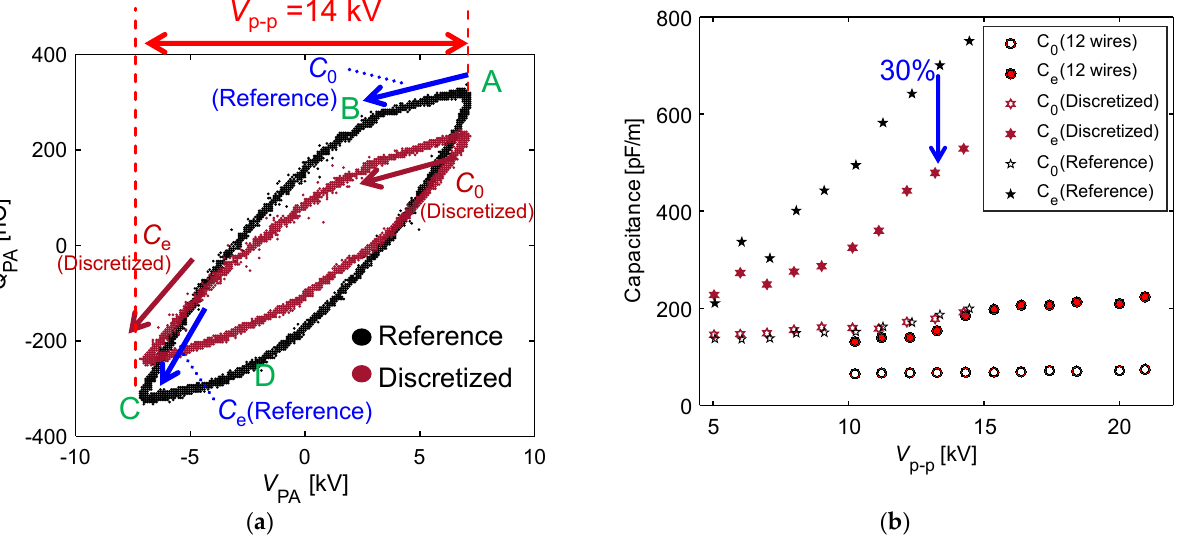
Figure 14. Plasma length ( L DBD ) estimated in section V as a function of ( a ) power consumption; ( b ) thrust.